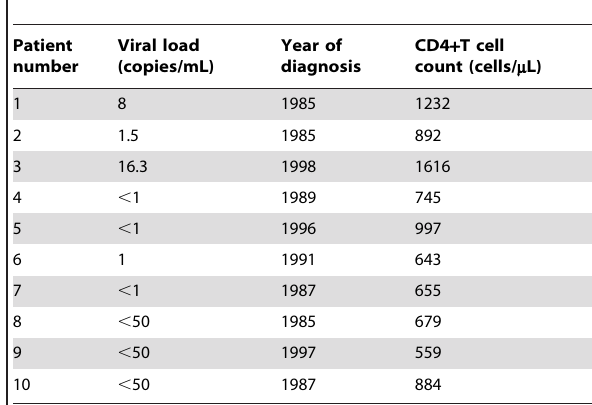
Table 1. Elite suppressor